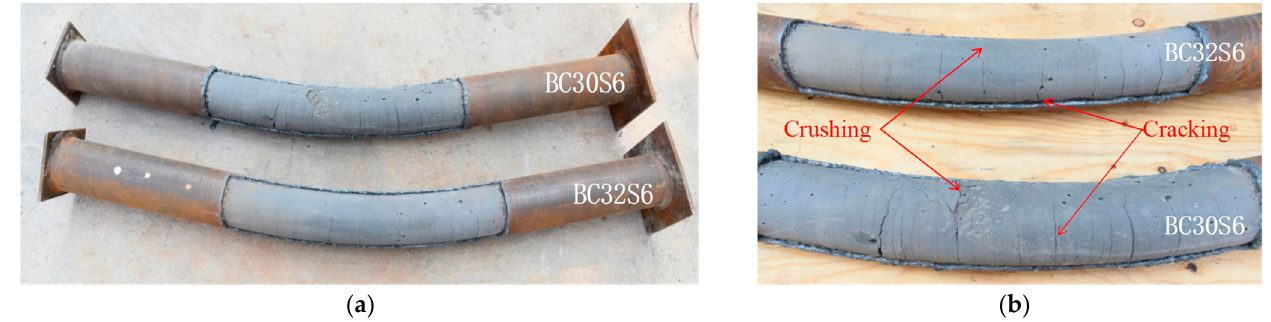
Figure 4. Failure modes of specimen and CA-UHPC infill. ( a ) Specimen; ( b ) CA-UHPC